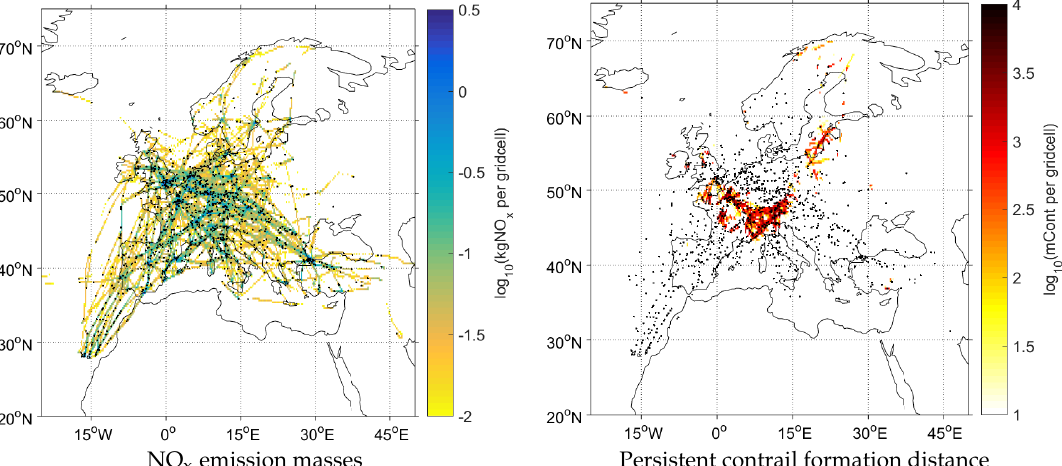
Figure 5. NO x emissions ( left ) and persistent contrail formation distance ( right ) per gridcell (0.25 ◦ × 0.25 ◦ ) integrated over a time period of 20s on 18 December 2015, 12:00 p.m. UTC. Single aircraft are represented as black dots (1216 in total). Note that a low pass filter was applied to the distributions in order to visualise the prior flight path.